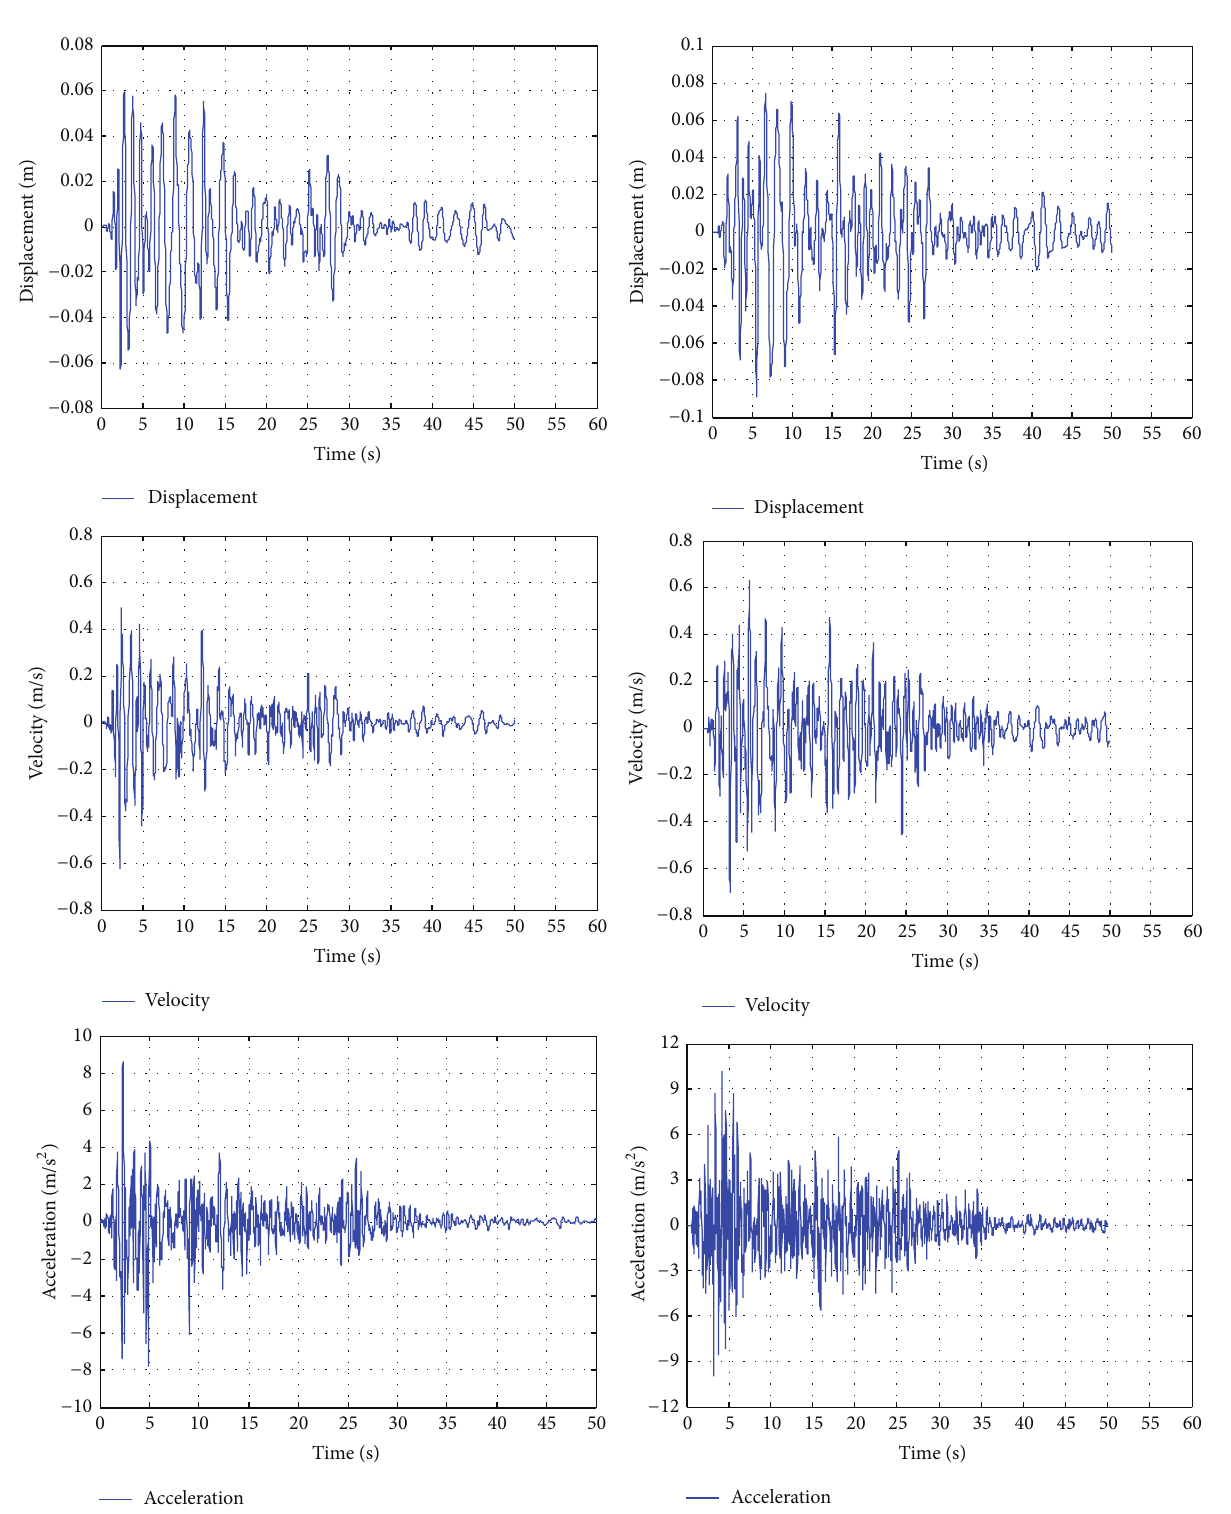
Figure 7: Dynamic responses of abutments ( 𝑉 𝑤 = 200